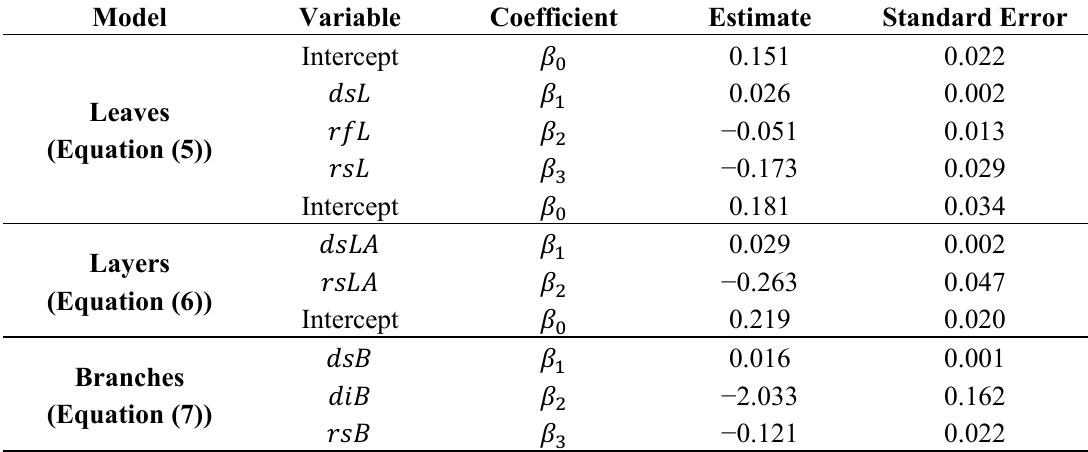
Table 2. Regression coefficients of the best reduced models for the leaves, layers and branches